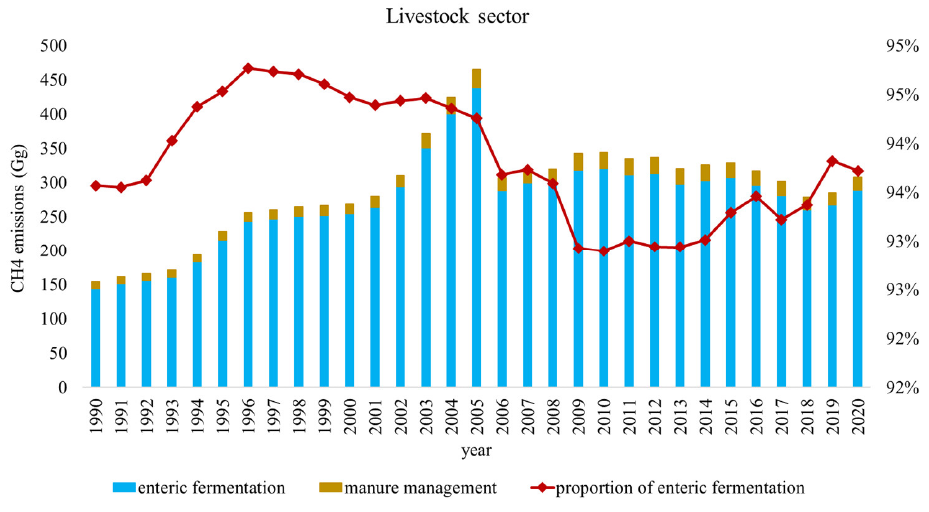
Figure 6. CH 4 emissions from livestock sector, 1990–2020. The trend of annual CH 4 emissions from enteric fermentation depends on the amount of livestock rearing. In 1990–1993, the average annual growth rate of CH 4 emission was